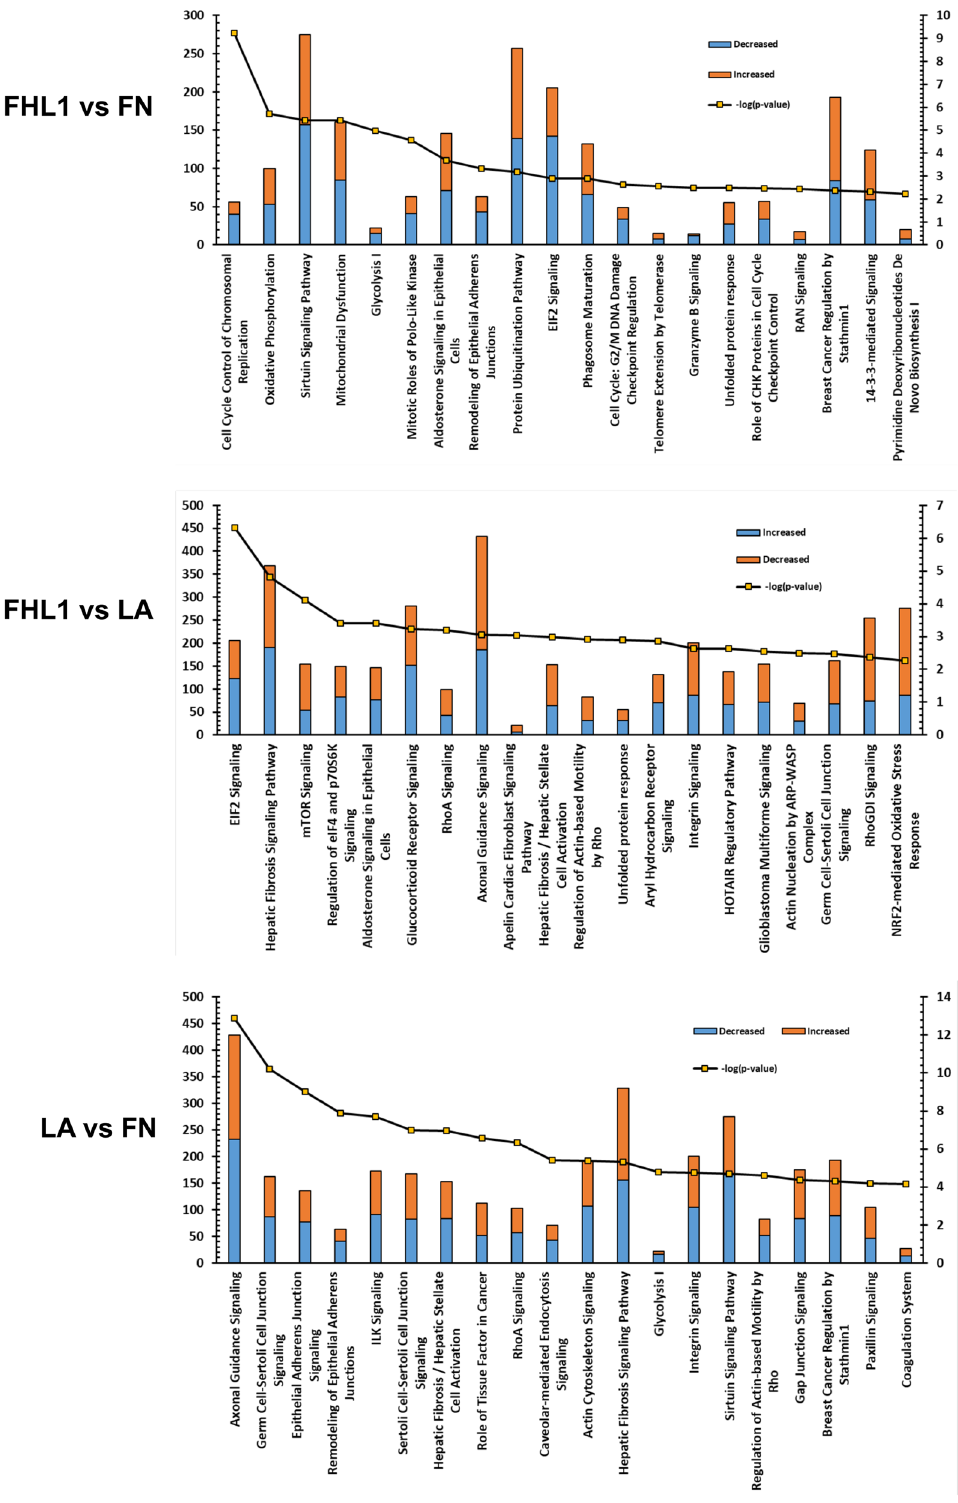
Figure 6. IPA analysis of differentially expressed genes in the most significantly altered canonical pathways. Bar charts indicate the most significantly different canonical pathways and the number of differentially expressed genes for each substrate comparison. Blue indicates decreased expression; orange genes indicate increased expression according to each comparison (measured on the left axis) and the line indicates significance as -log p value (measured on the right axis). “Data were analysed through the use of IPA (QIAGEN Inc., https:// www. qiage nbioi nform atics. com/ produ cts/ ingen uityp athway- analy